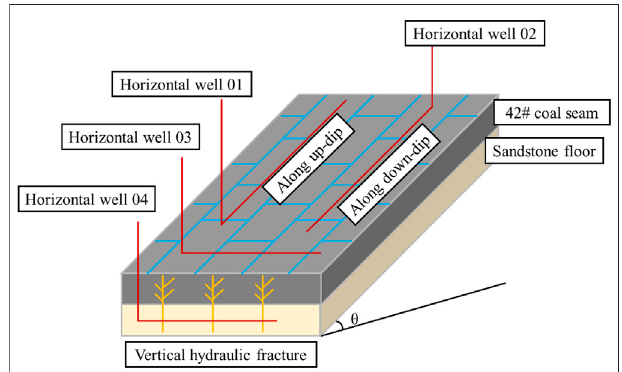
FIGURE 7 | Different well-drilling styles: well 01 was drilled along the up- dip direction; well 02 was drilled along the down-dip; well 03 was drilled along the direction ofthe coal seam trend;and well 04 wasahorizontalwell drilled in the coal seam fl oor with vertical fractures through a speci fi c staged fracturing